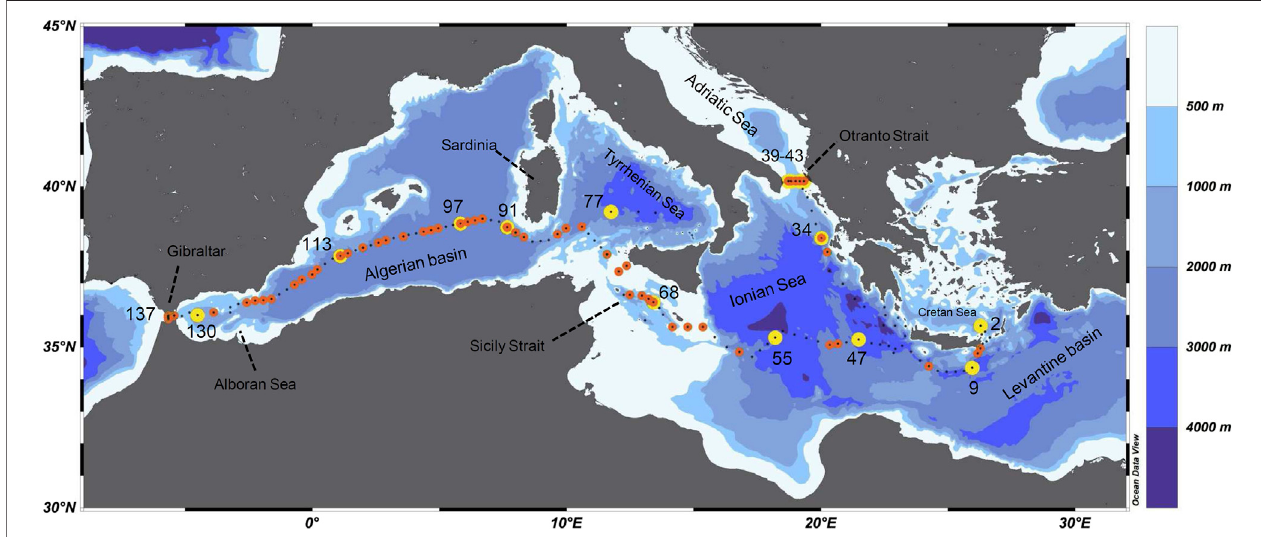
FIGURE 1 | The study area map annotated with major features discussed in the text. Black dots correspond to CTD casts; orange circles correspond to stations where optical parameters of particulate matter were obtained by using the LISST-Deep; while yellow circles correspond to stations where seawater samples were collected for the elemental and stable isotopic analysis of carbon and nitrogen of particulate